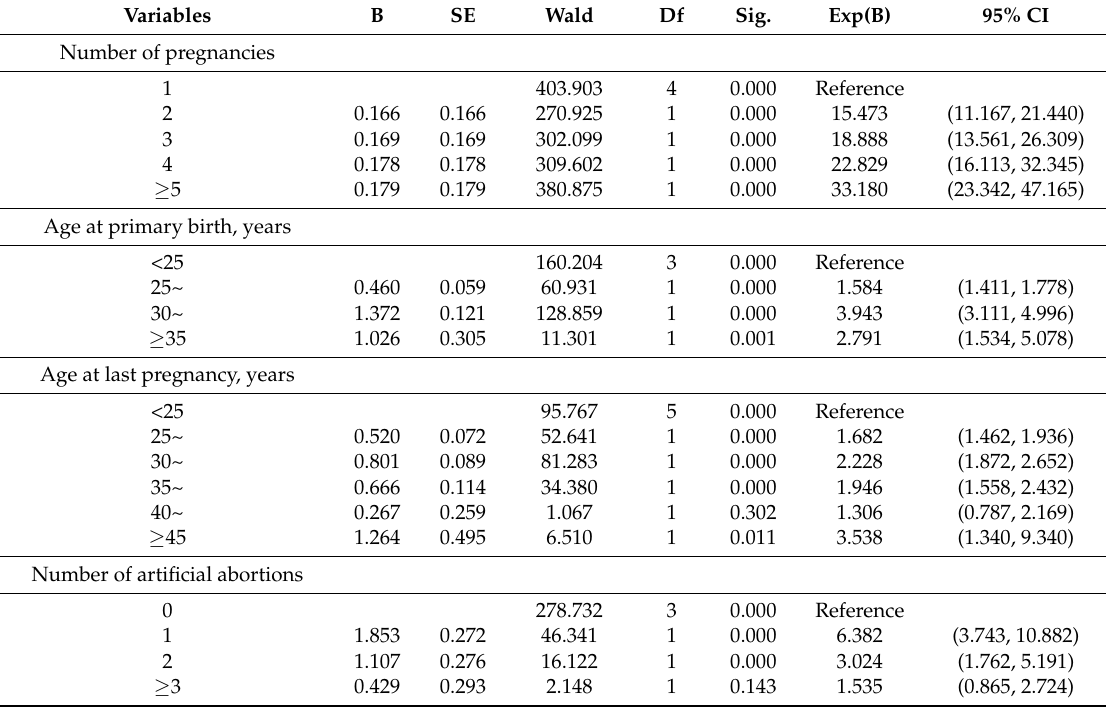
Table 5. The Association of Reproductive Status Risk Factors on Spontaneous Abortion in the Jinchang Cohort